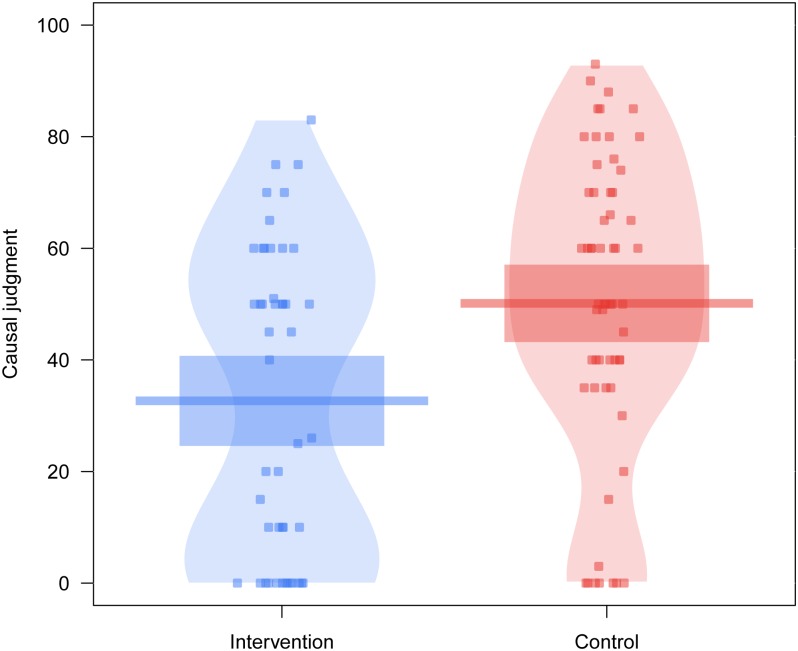
Intensity of the causal illusion.For each condition, the points represent the raw data, the horizontal lines represent the mean causal judgments, and the rectangles the 95% confidence intervals.